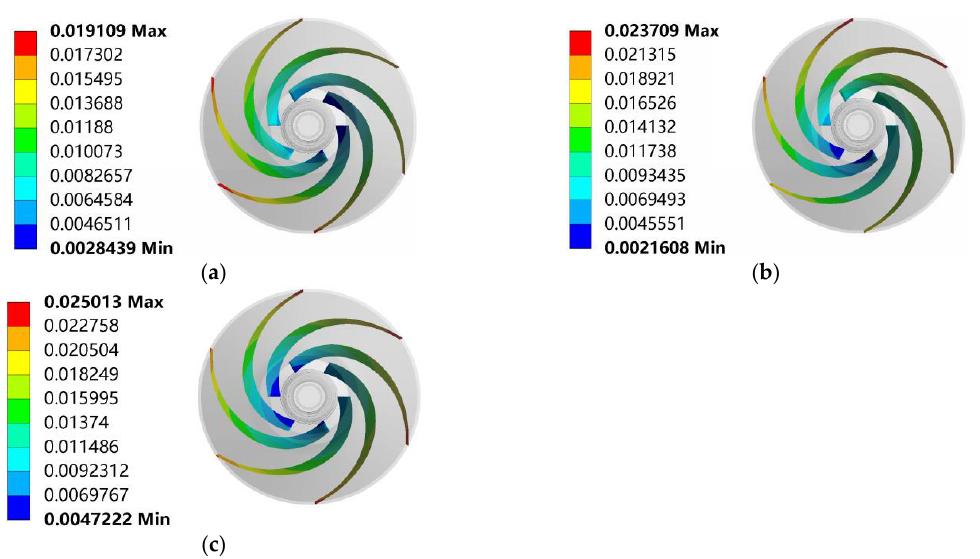
Figure 12. Deformation of fluid-structure interaction in blade, mm. ( a ) 0.4 Q d . ( b ) 1.0 Q d . ( c ) 1.3 Q d .